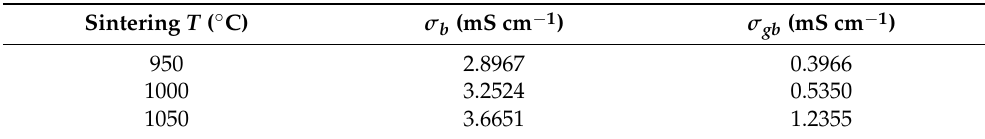
Figure 7. Impedance spectra for LASTP-750 pellet. Table 3. Bulk and grain boundary conductivities of the LASTP